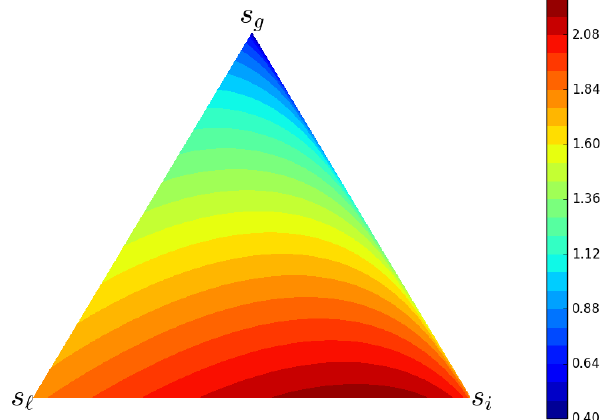
Figure 6. Model dependence of effective thermal conductivity on liquid- ( s (cid:96) ), ice- ( s i ) and gas-phase ( s g ) fraction of